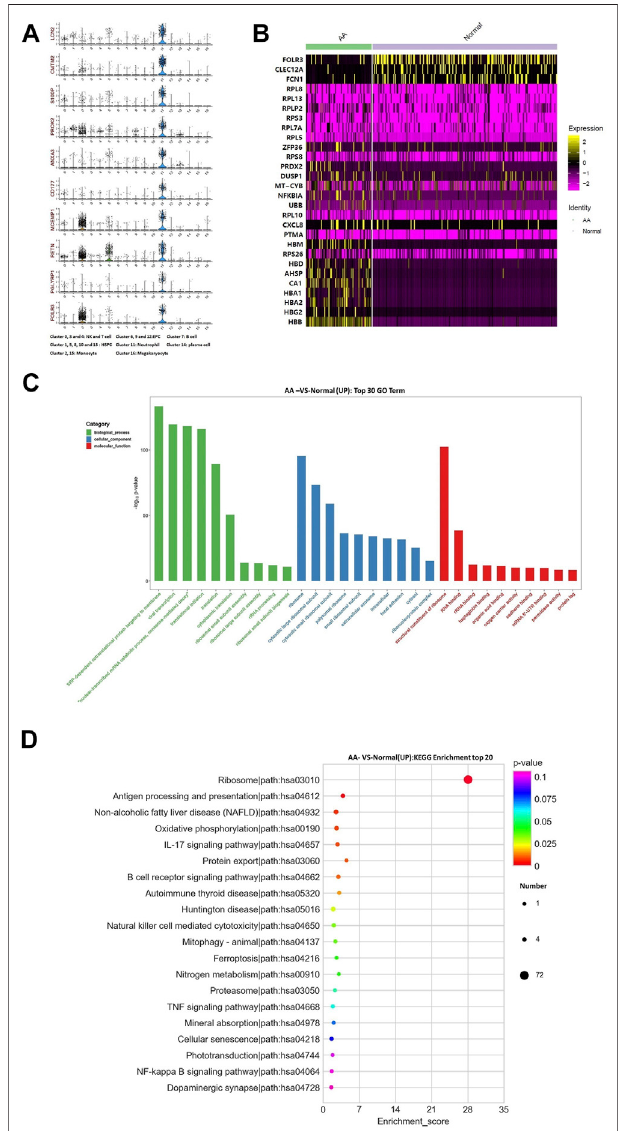
FIGURE 6 | Gene alterations in neutrophil granulocytes from AA patients. (A) Violin plot of the top 10 marker genes in neutrophil granulocytes. (B) Heatmap of differentially expressed genes in neutrophil granulocytes. (C) GO analysis of upregulated genes in neutrophil granulocytes. (D) KEGG pathways of upregulated genes in neutrophil